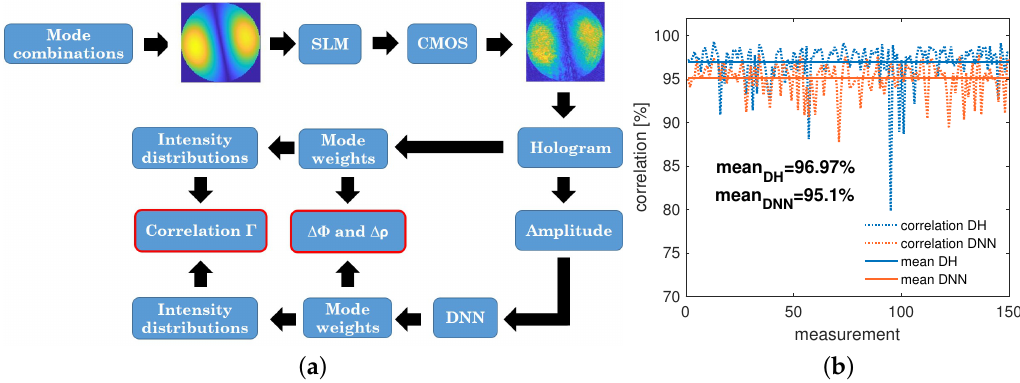
Figure 5. ( a ) Illustration of the scheme for data acquisition. ( b ) Correlation coefficients using DH and the prediction of a DNN,